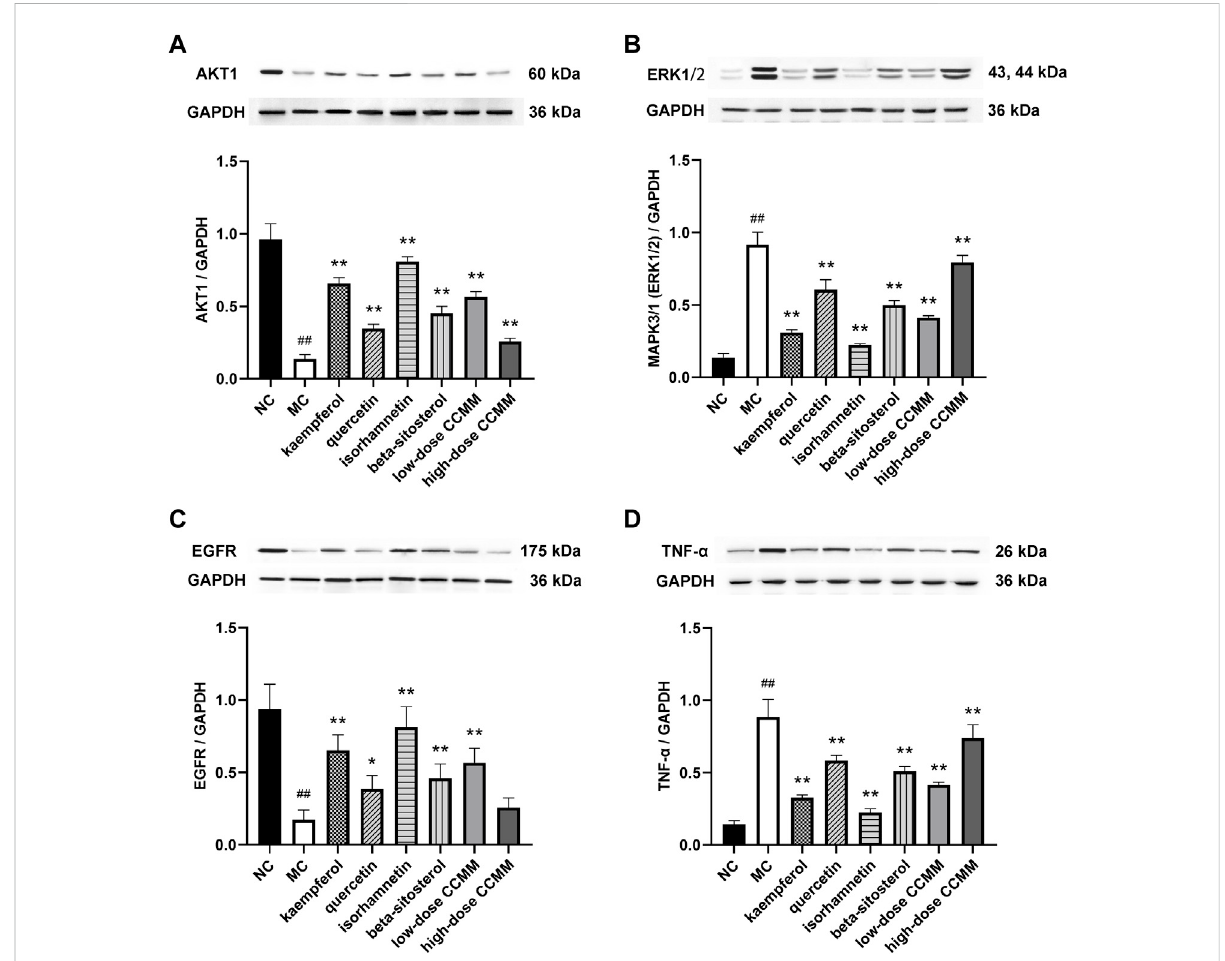
FIGURE 14 WesternblotanalysisandquantitativedataofAKT1 (A) ,MAPK3/1(ERK1/2) (B) ,EGFR (C) ,andTNF- α (D) oftesticulartissuesineachgroup.Data:n=5, mean ± SD, experiments performed in triplicate. ## p < 0.01 versus the NC group, * p < 0.05 versus the MC group, ** p < 0.01 versus the MC